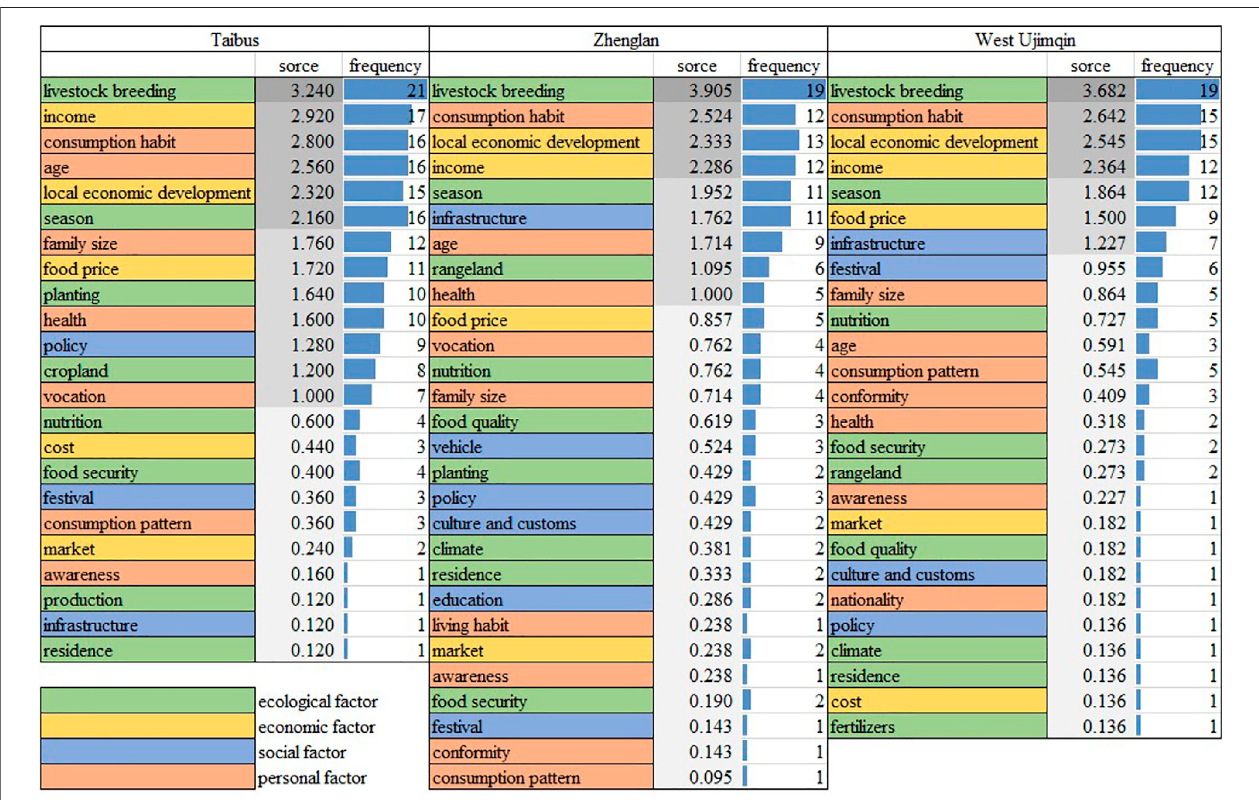
FIGURE3| Impact factor types onfood consumptioninthe threetypical studyareas,thescore ofimpactfactors on foodconsumption, and thefrequencyofeach impact factor mentioned by respondents. Note: Degree of in fl uence scores were divided into four grades and marked by different colors. Data source: results from our 2019 fi eld survey and developed from our previous study (Yang and Zhen,